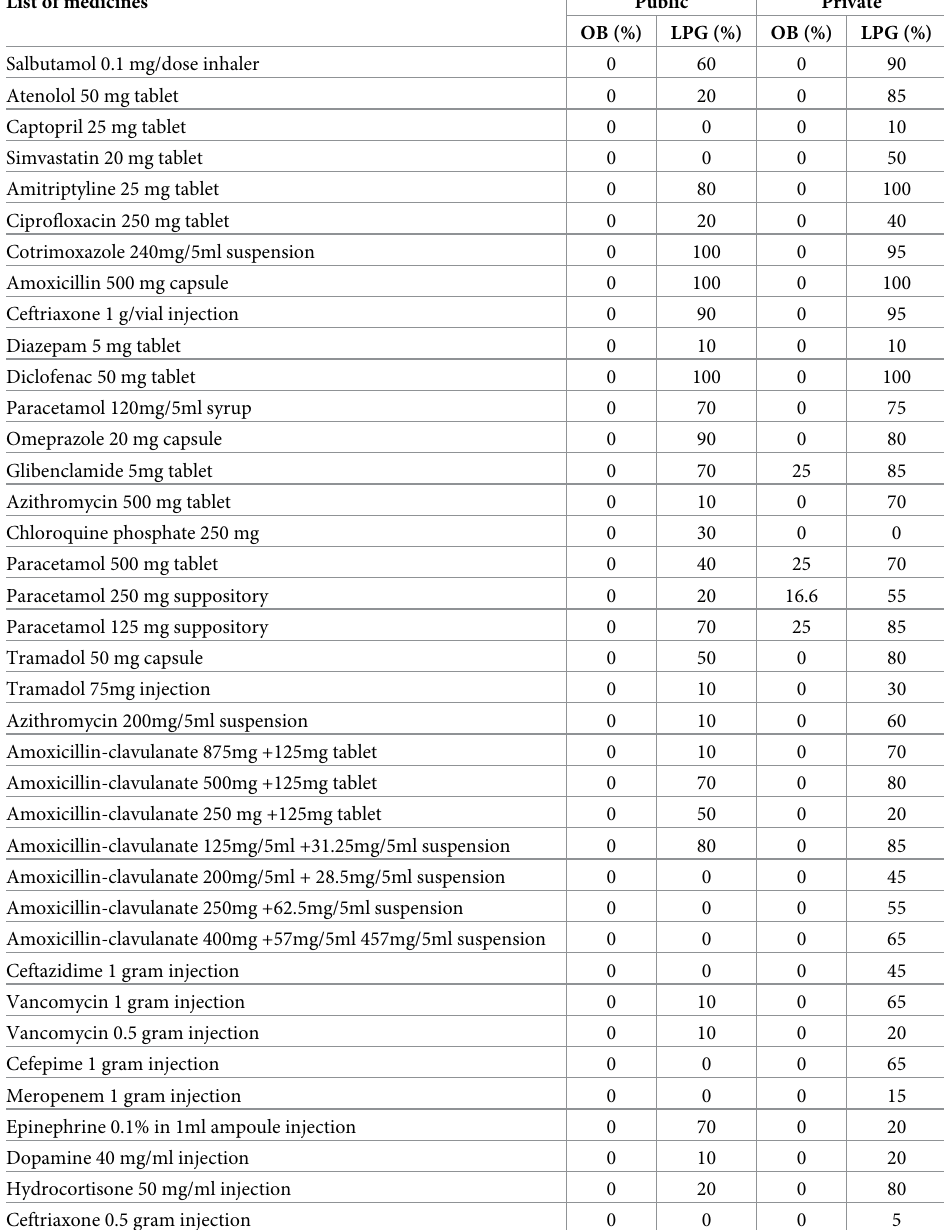
Table 1. Period availability of medicines in health facilities of Dessie town,